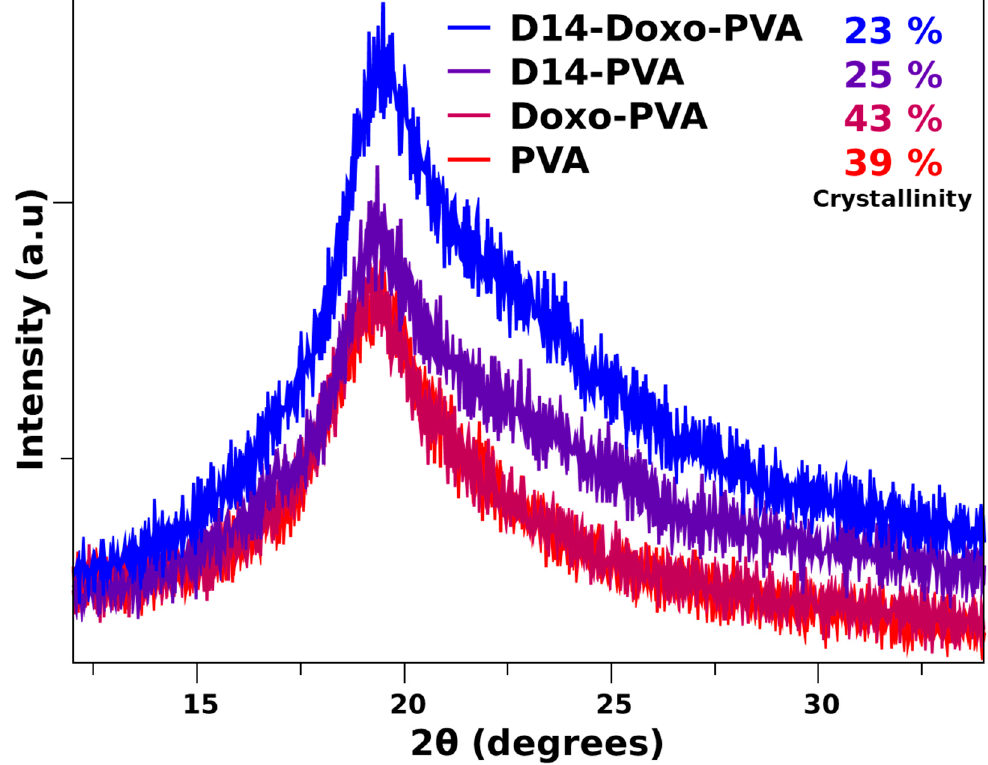
Figure 4. X-ray diffraction pattern of PVA sphere and loaded with D14, doxo and D14-Doxo. Aiming to illustrate the chemical interactions between the polymer and the drugs, molecular docking studies were used. A strong interaction of D14 with PVA was observed. As shown in Figure 5A, the D14 molecule binds to the hydrophobic cavity of PVA, confirming the data observed in the experimental results (Figures 2–4). However, doxo binds only with a portion of its structure on PVA (Figure 5B), suggesting a weakened interaction, and the major part of the doxo structure keeps interacting with the solvent, probably through hydrogen bonds. Due to the non-polar nature of D14, polar characteristics of doxo and previous experimental studies, these results were expected.